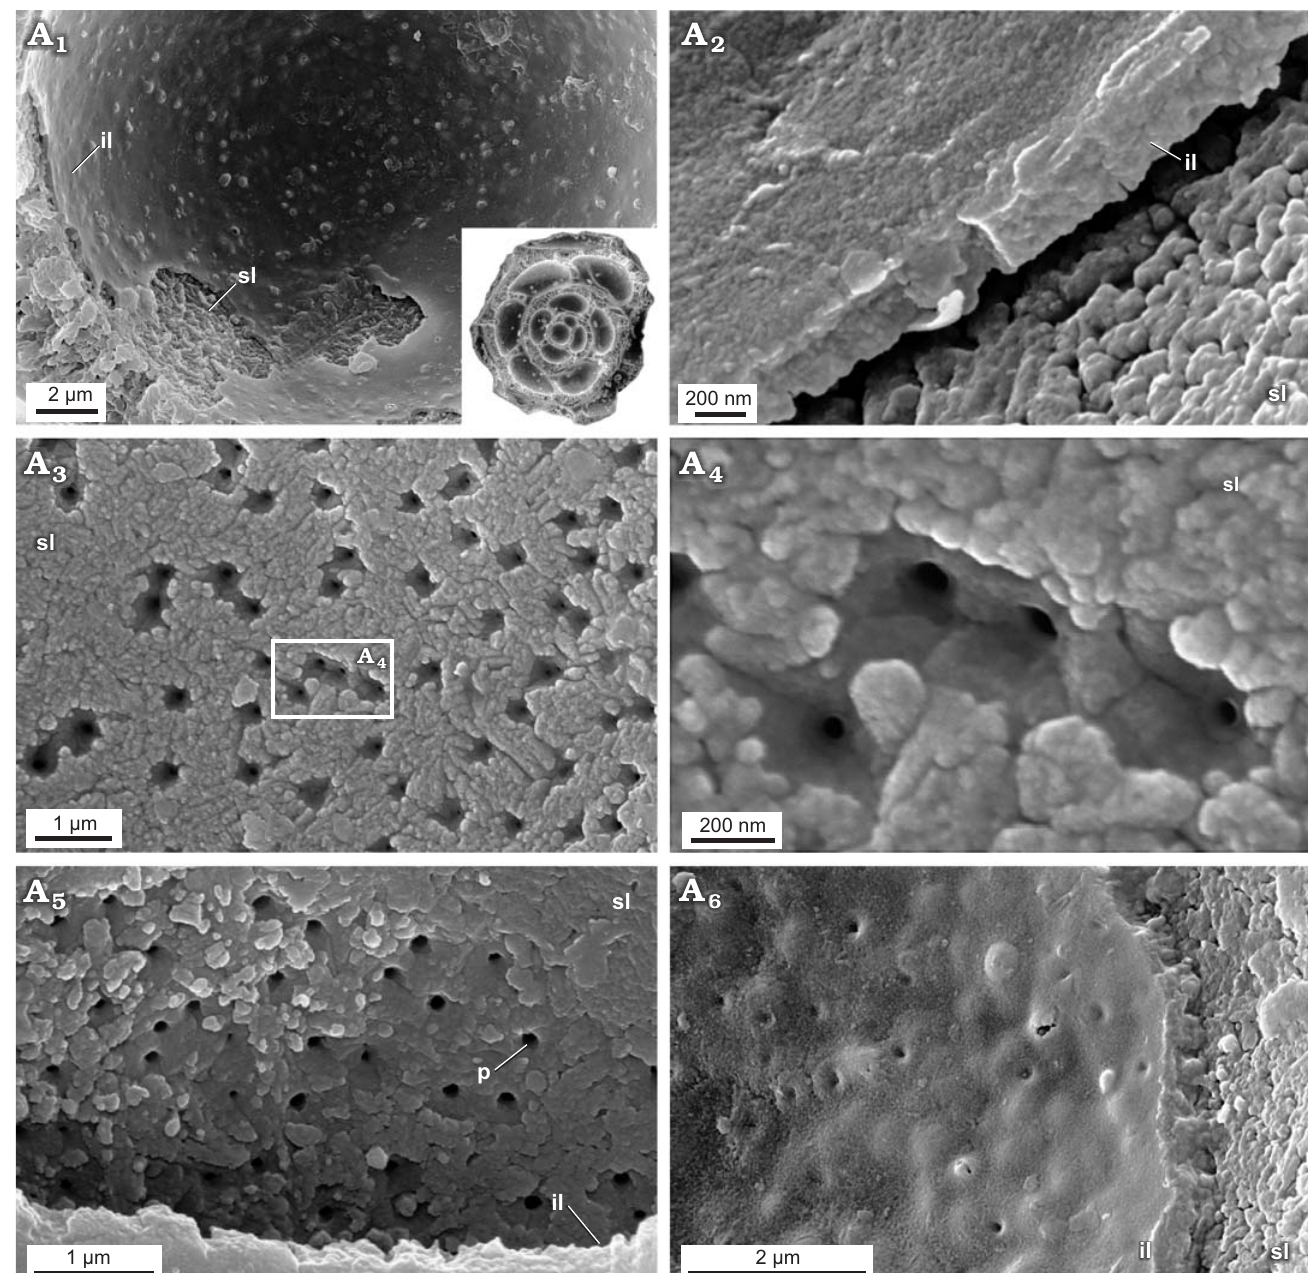
Fig. 5. FESEM images of the test structure in Epistomina nuda Terquem, 1883, MWGUW ZI/67/54/20 (Robertinida, Globothalamea) from the Jurassic of Gnaszyn, Poland; views from the chamber interior showing the finely porous and nanogranular texture of both the surface of the internal layer and the inner lamina. Front view of the chamber interior (A 1 ); oblique cross-sectional view of inner lamina (A 2 ); front view of the surface of internal layer (A 3 , A 5 ); significantly magnified view of the internal layer surface (A 4 ); oblique view of the inner lamina (A 6 ). Abbreviations: il, inner lamina; p, pore; sl, surface of internal layer (columnar